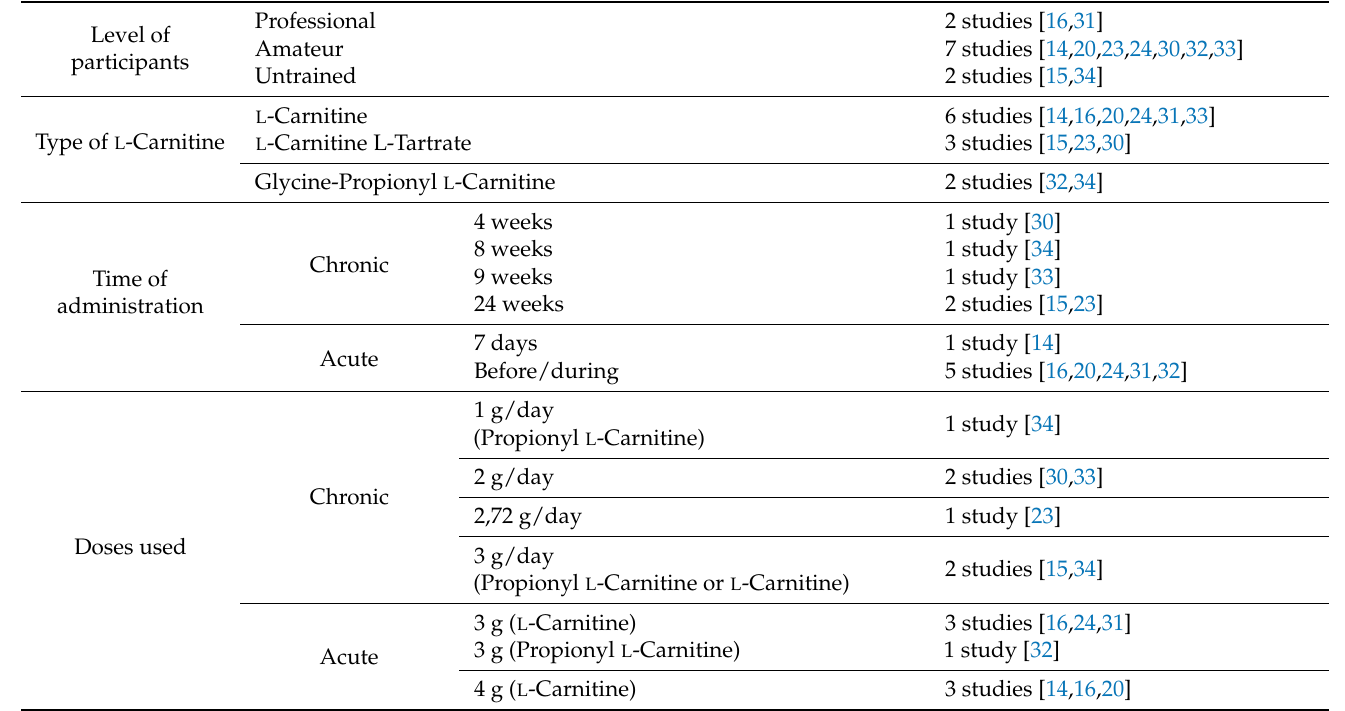
Table 2. Participants and intervention characteristics of the studies included with the systematic review.